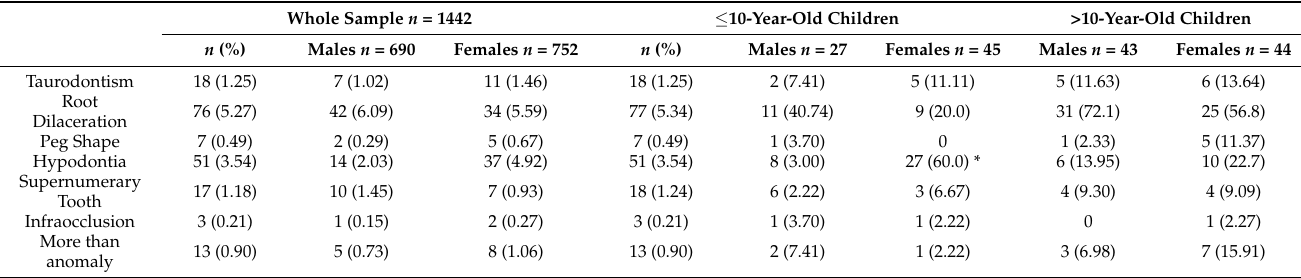
Table 4. Prevalence of different anomalies among sex and age groups.